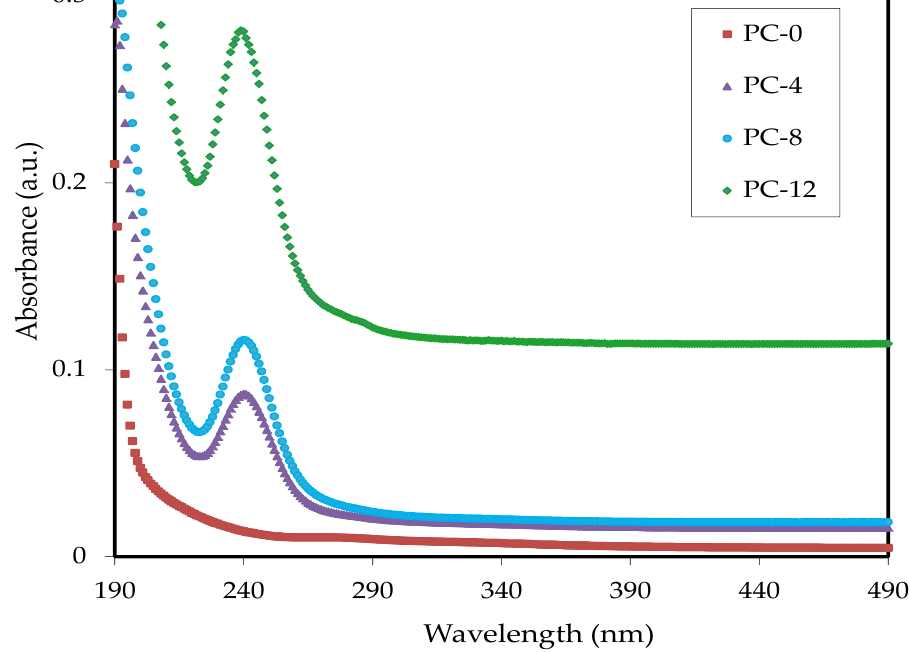
Figure 4. Absorption spectra over UV and the short visible region corresponding to PVA and PVA-loaded samples.